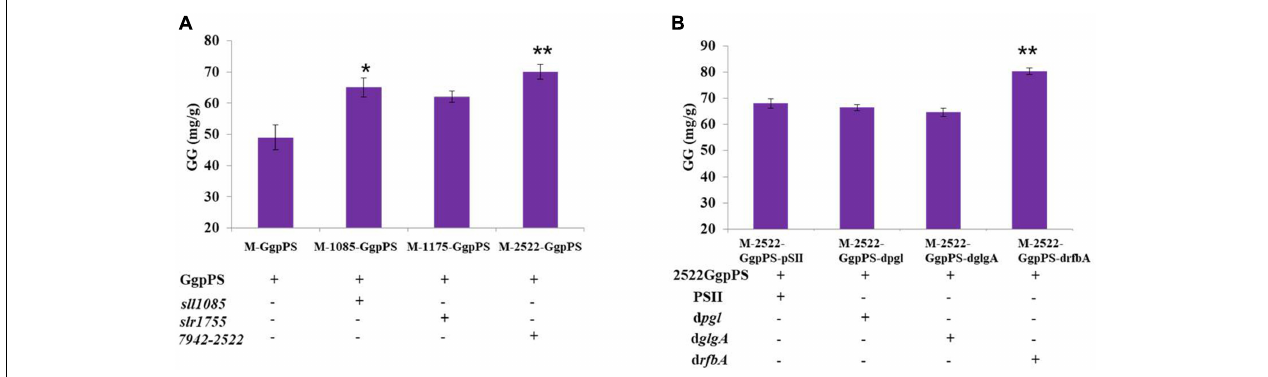
FIGURE 4 | (A) GG synthesis of strains M-GgpPS, M-1085-GgpPS, M-1175-GgpPS, and M-2522-GgpPS; (B) GG synthesis of strains M-2522-GgpPS-pSII, M-2522-GgpPS-dpgl, M-2522-GgpPS-drfbA, and M-2522-GgpPS-dglgA. Statistical analysis was conducted as described in the text, as statistical significance indicated by ** p < 0.01; * p < 0.05.